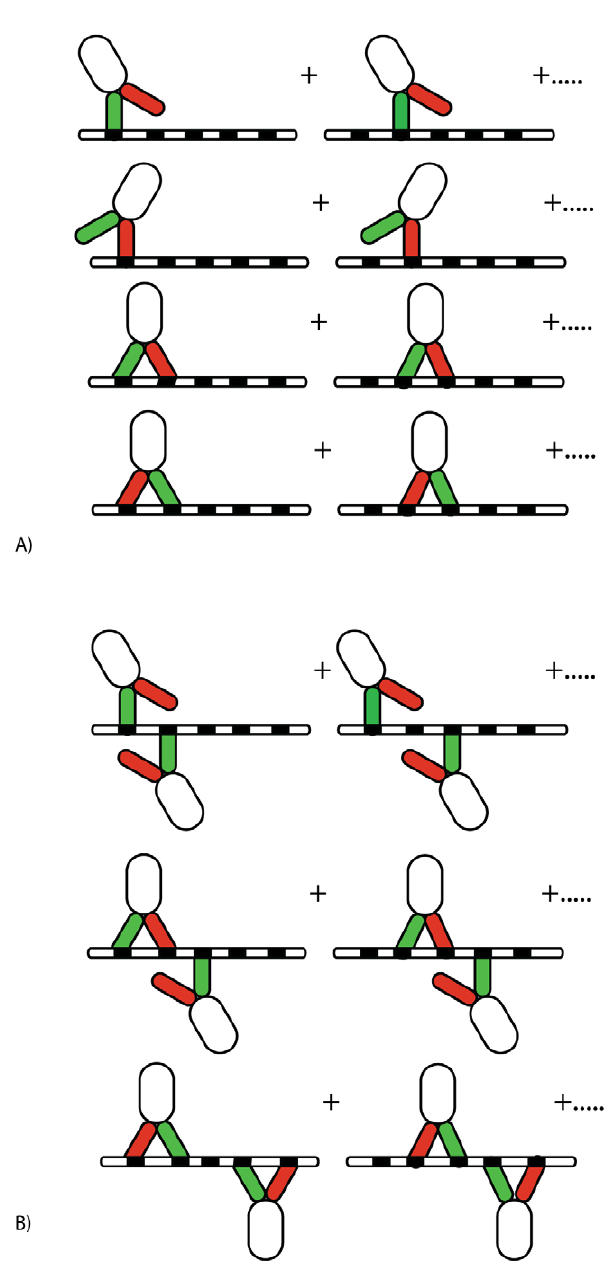
Figure 7. Combinations of 1:1 and 2:1 Grb2-Sos1 complexes. A) In the 1:1 Grb2-Sos1 complex, Grb2 can be bound to Sos1 through one or both SH3 domains (shown in green and red) to polyproline motifs (black boxes) on the unstructured C-terminus tail of Sos1 (represented by an oval). B) In the 2:1 Grb2-Sos1 complex, each Grb2 can be bound to Sos1 through one or both SH3 domains to the 1 polyproline motifs on Sos1. The SH2 domain of Grb2 is shown as a white oval shape connected to the SH3 domains.